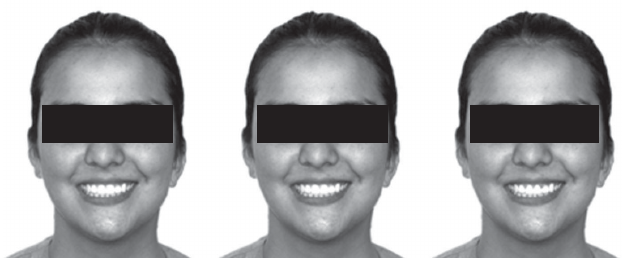
Fig. 5 - Female ovoid facial contour set. Each photograph presents a different shape of upper central